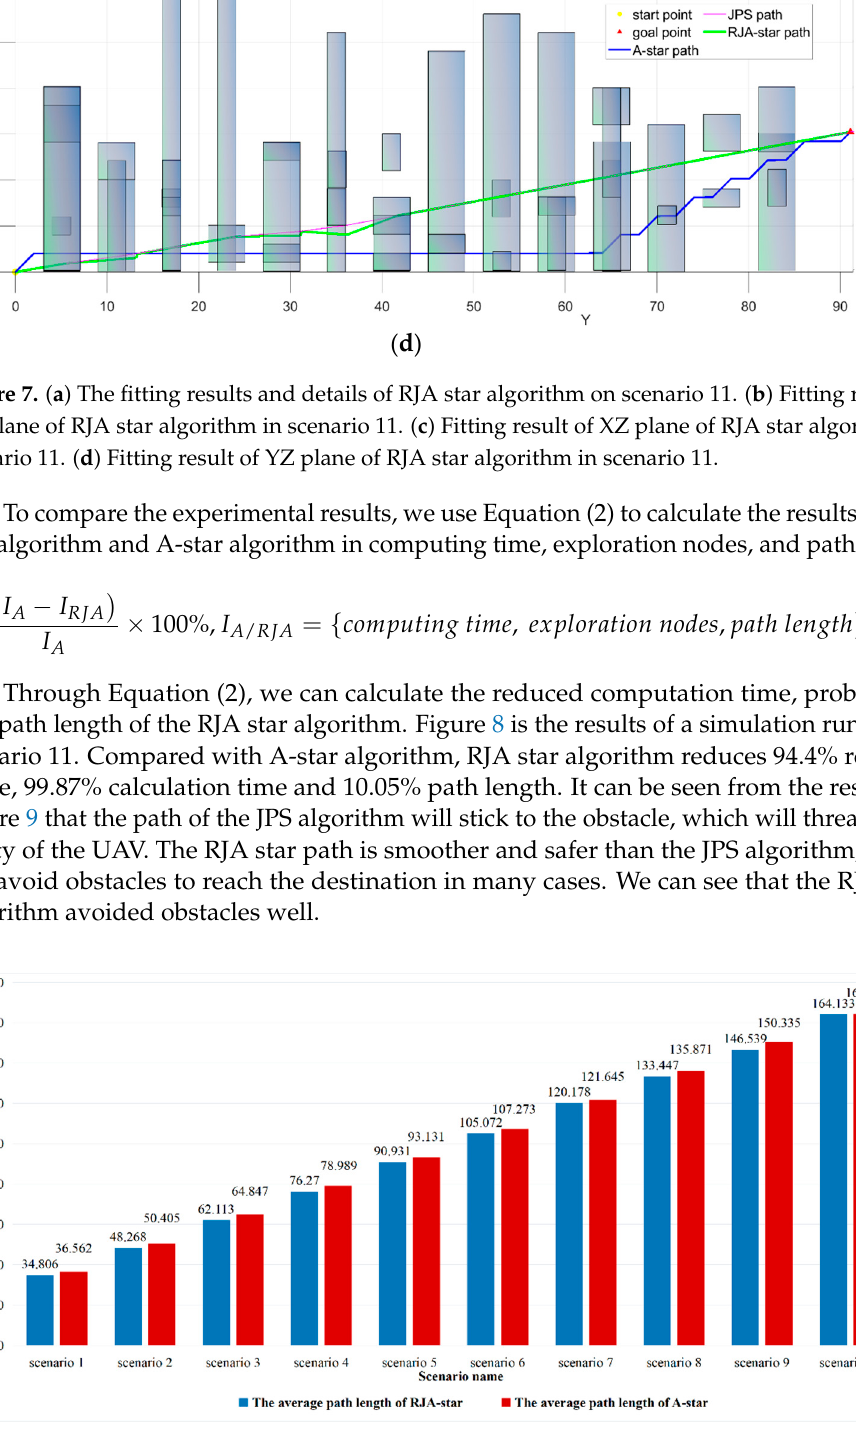
Figure 9. Comparison of two algorithms for exploring nodes.